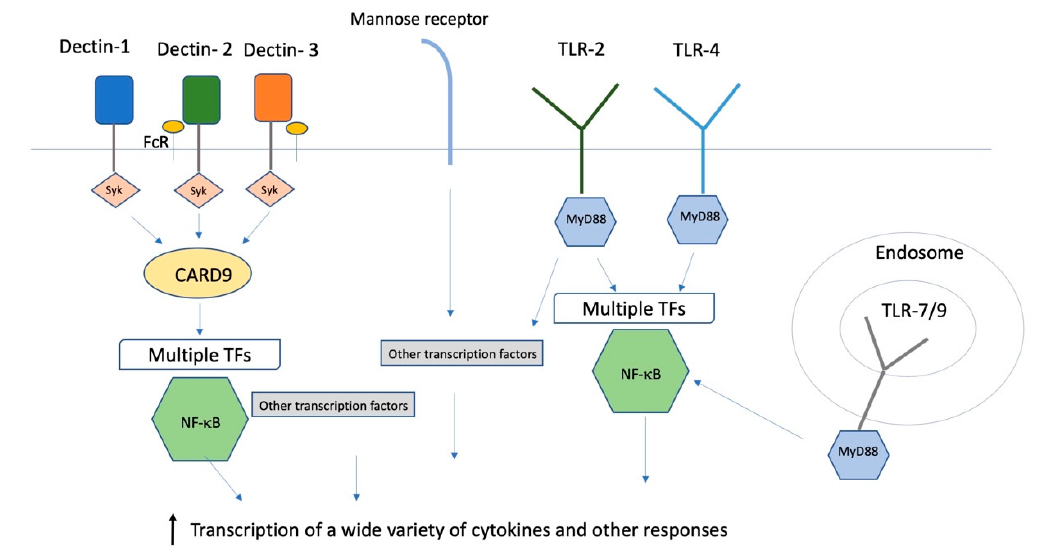
Figure 1. Innate immune receptors and transcription factors. A simplified schematic summary of some of the receptors and intracellular transcription pathways for the innate immune response to fungi. FcR: Fc receptor; TLR: toll like receptor; syk: signal transduction kinase; MyD88: Myeloid differentiation primary response 88; CARD9: caspase recruitment domain family, member 9; TFs: transcription factors.